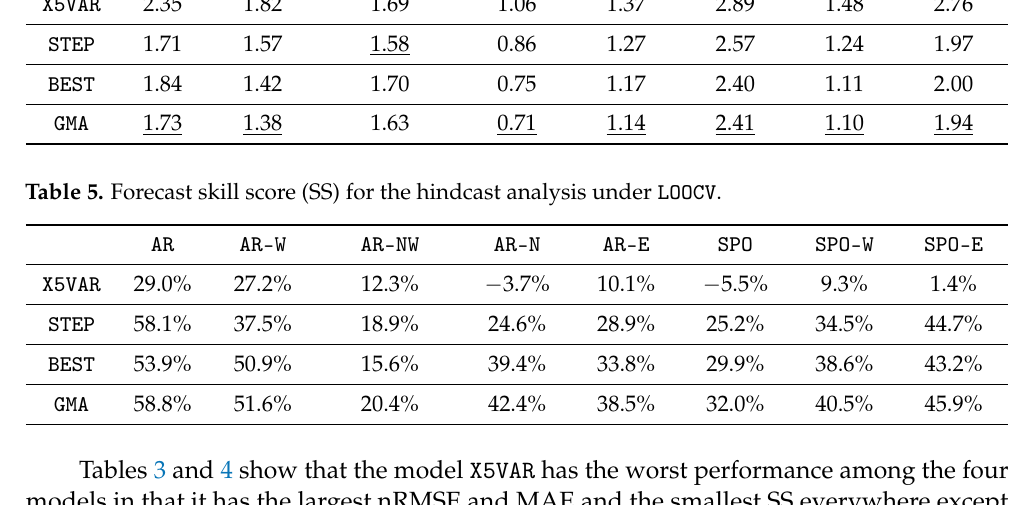
Table 4. MAE statistic for the hindcast analysis under LOOCV . The best result for each region is under- lined. AR AR-W